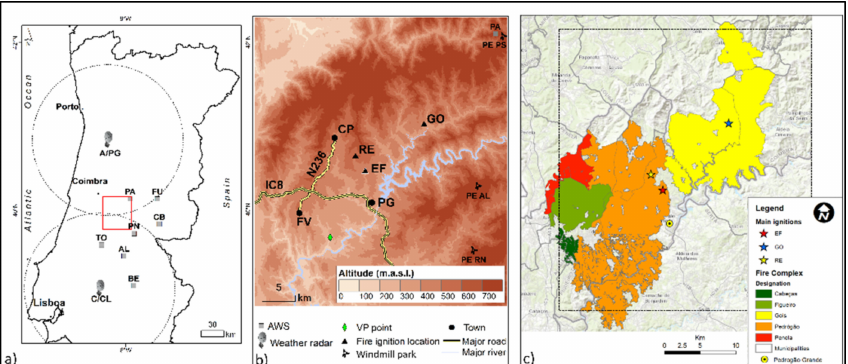
Figure 1. ( a ) Map of Portugal with the location of the relevant automatic weather (AWS) and radar stations. ( b ) Zoom in of the fire complex area with the terrain altimetry; important locations (including the accessed video cameras in PG and windmill parks, PE RN, PE AL and PE PS); roads; vertical profile of numerical model (VP) and relevant fire ignitions (EF—Escalos Fundeiros, RE—Regadas and GO—G ó is). The square in ( a ) marks the zoomed in area of ( b ). ( c ) Map of the complex of fires of Pedr ó g ã o Grande. The square in ( c ) matches the zoomed in area of ( b